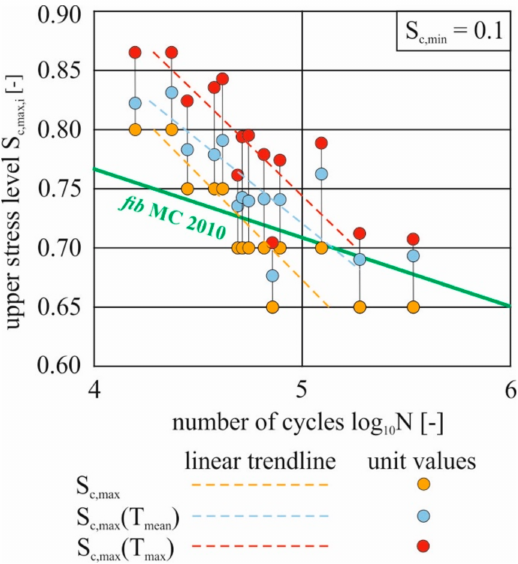
Figure 6. Numbers of load cycles N achieved in the experiments and associated linear trend lines, displayed according to the maximum stress level as scheduled and to maximum stress levels adjusted to the maximum measured temperature as well as the average temperature during the